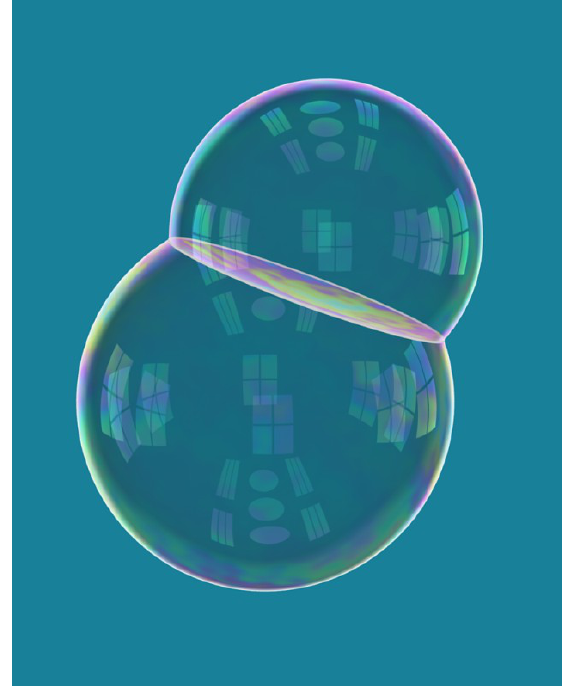
Figure 1: The standard double bubble provides the least-perimeter way to enclose and separate two given volumes in R 3 with density 1. We consider more general densities. Image from John M. Sullivan, http://www.math.uiuc.edu/~jms/Images.